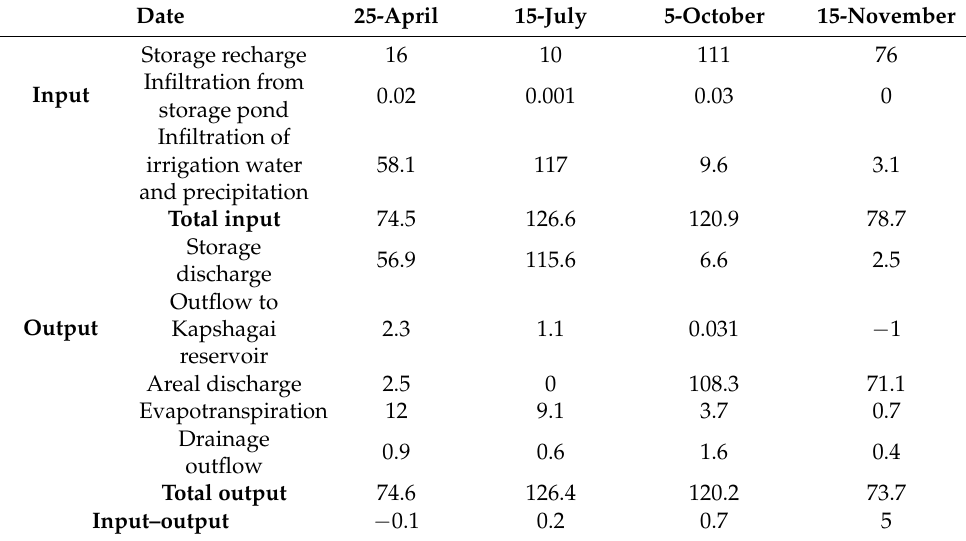
Table 1. Groundwater-flux balance at the Shengeldy experimental site was calculated for April, July, October, and November 2017. The results of the model calibration are in thousands of m 3